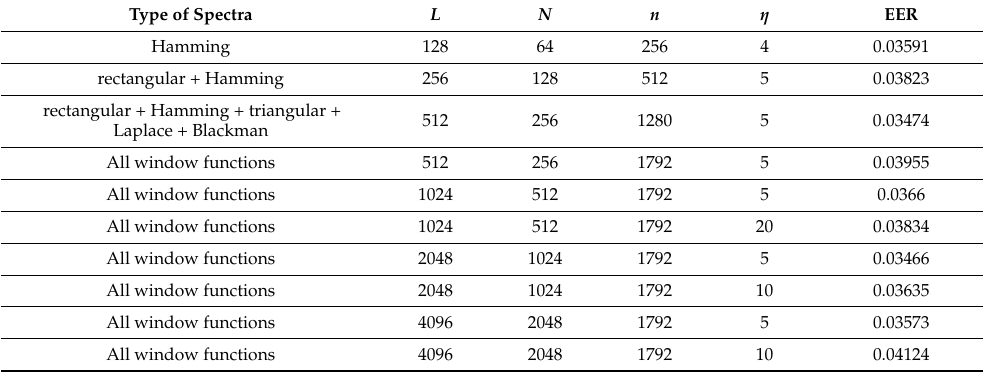
Table 5. Error probabilities of user personality verification with the image of one ear using combined features extracted by both encoders (at C + = 0.5, C - = 0.5, AUC MAX = 0.3, K G =